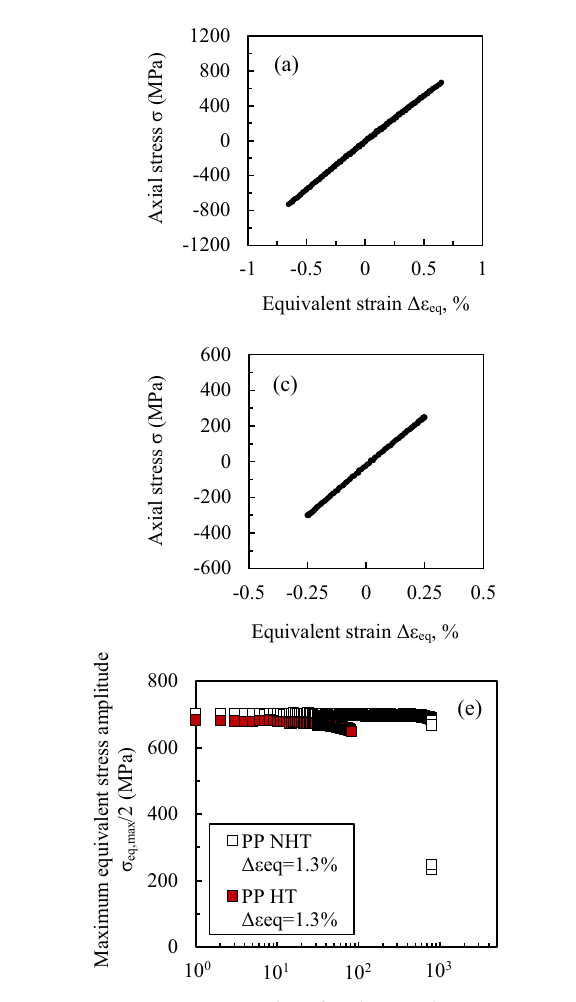
0.5% of c CI HT and d CI NHT, and maximum stress =